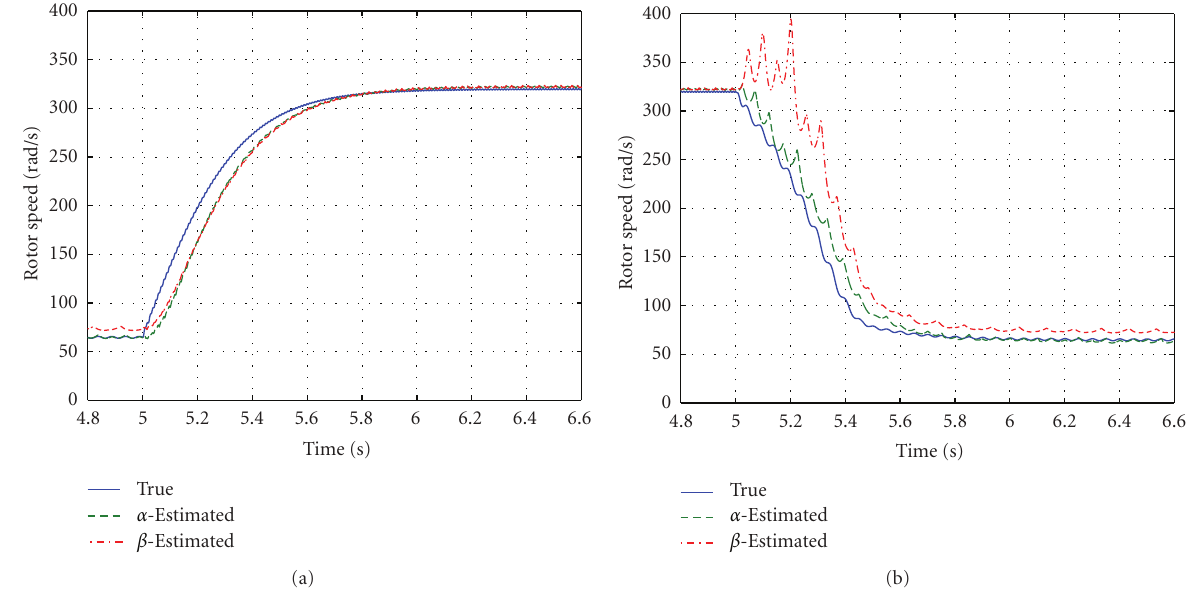
Figure 7: Rotor speed ω r of the SPIM and its estimations (cid:6) ω rα and (cid:6) ω rβ during steps in the frequency stator (computational simulation): (a) from 10 Hz to 50Hz, (b) from 50 Hz to 10